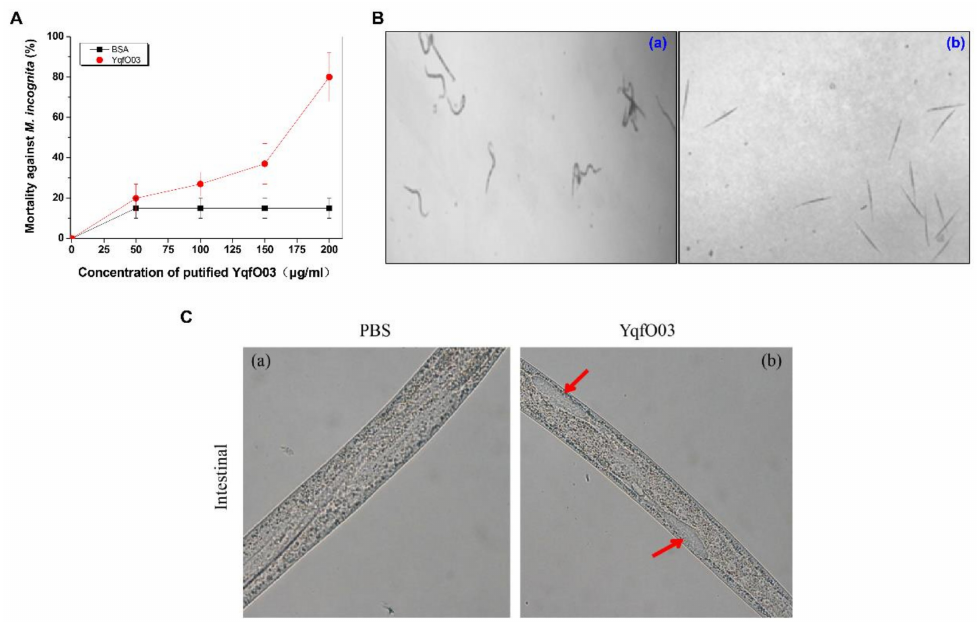
Figure 4. ( A ) Nematicidal activity assay of purified YqfO03, ( B ) Morphology of YqfO03-killed M. incognita worms, and ( C ) Micrographs of M. incognita after YqfO03 treatment. In ( A ), Mortality assays of M. incognita js2 that were incubated at different concentrations of 0, 50, 100, 150, and 200 µ g/mL, of purified YqfO03 protein. BSA was used as the control. The mortality of the worms in each well was determined in 5 d. Error bars represent the standard deviations from the means of three independent experiments. In ( B ), ( a ) normal worms treated with BSA; ( b ) dead worms after incubated with YqfO03. In ( C ), ( a ) worms treated by phosphate-buffered saline (PBS) (pH 7.0) for 48 h; ( b ) worms treated by 500 µ g/mL YqfO03 for 48 h. red arrows indicate a patch-like structure in the intestinal region of